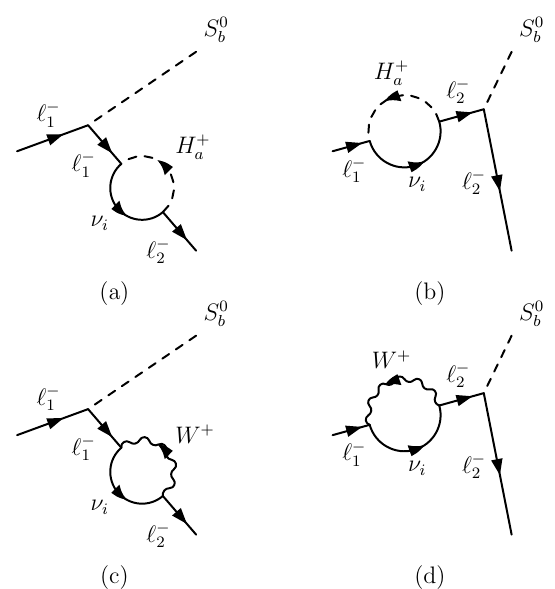
Figure 16 . The four self-energy-like diagrams for S 0